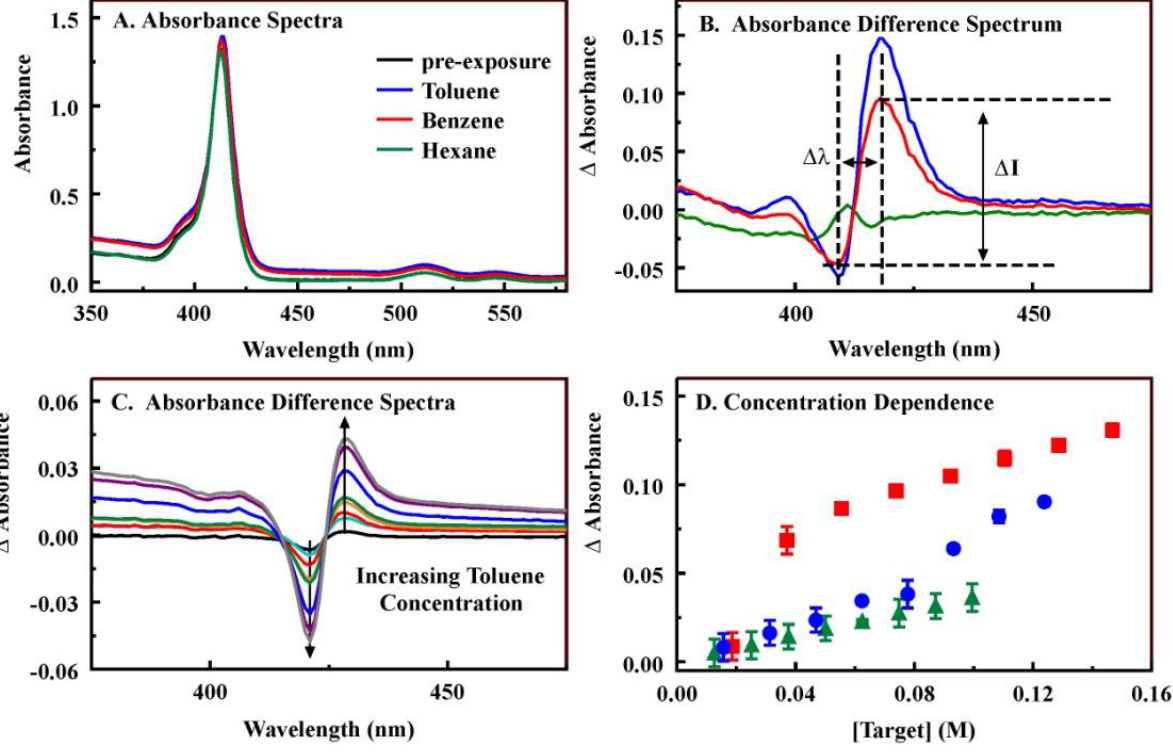
Figure 5. Changes in the porphyrin absorbance characteristics upon interaction with targets. Panel A, absorbance spectra of MnC TPP (4 μM) in the absence (black) and 1 presence of benzene (red), toluene (blue), and hexanes (green) (200 mM, in 95% methanol). Panel B, difference spectra calculated as post-exposure minus pre-exposure absorbance from Panel A. In this spectrum, the distance between the peak position and the trough position (∆λ) and the difference between the peak height and the trough depth (∆I) are indicated for the benzene interaction. Panel C, difference spectra resulting from the exposure of ZnC TPP (3.3 μM) to varying concentrations of toluene. Panel D, 4 concentration dependence of the interaction between ZnC TPP and the three 4